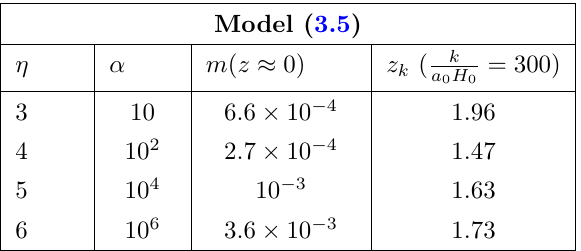
at current epoch f ,R